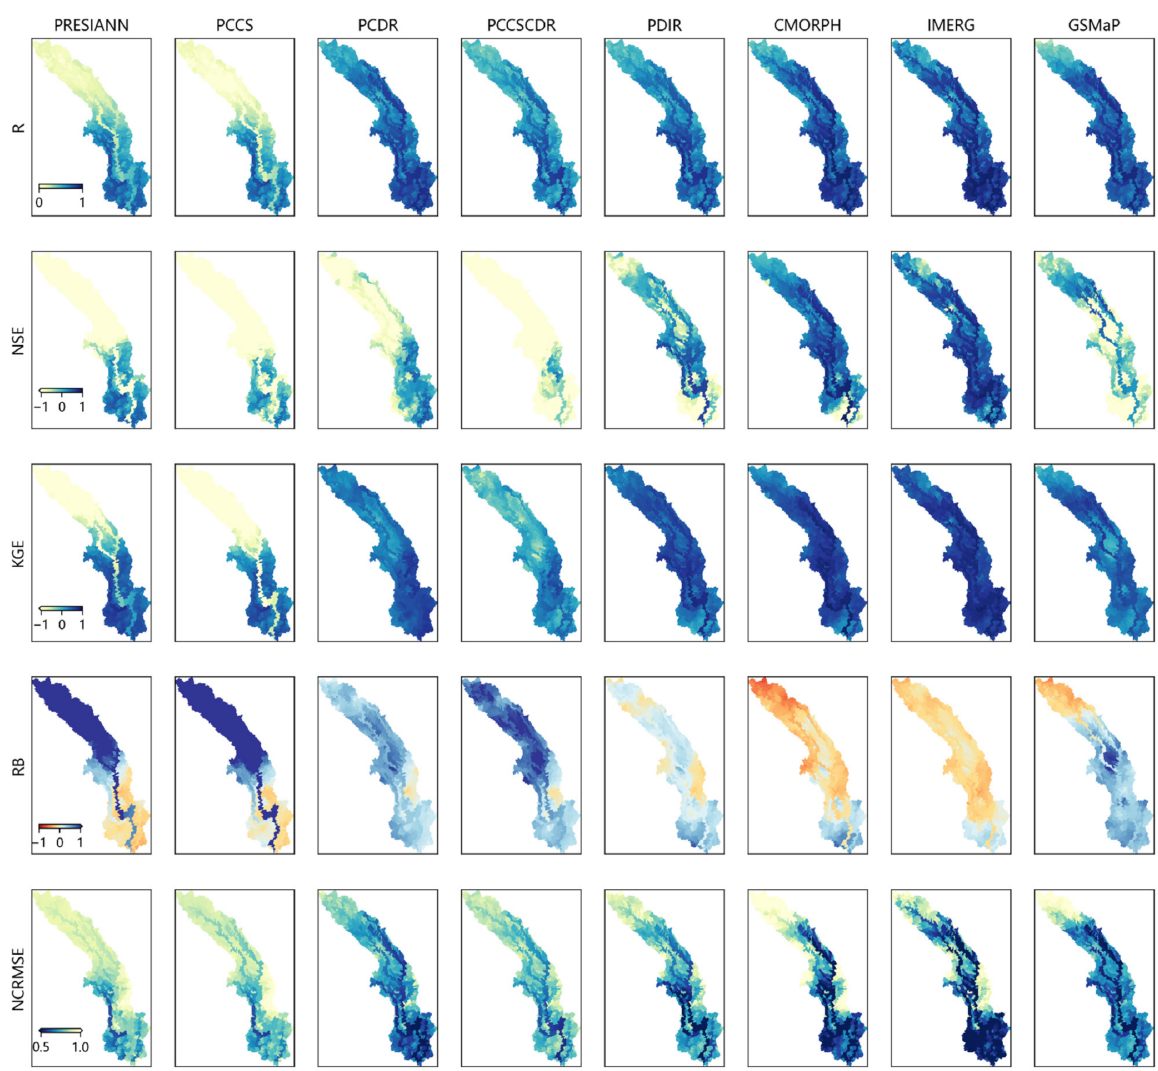
Figure 5. Spatial distribution of precipitation performance metrics of eight SPEs in YLJ basin. Pearson correlation coefficient (R); Nash–Sutcliffe efficiency (NSE); Kling–Gupta efficiency (KGE); Relative bias (RB); Normalized centered root mean square error